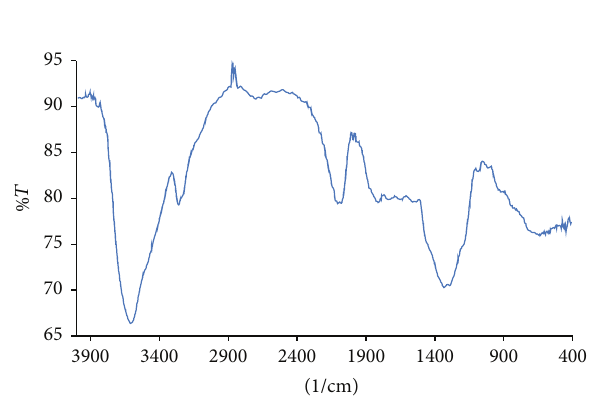
Figure 1: FTIR spectra of